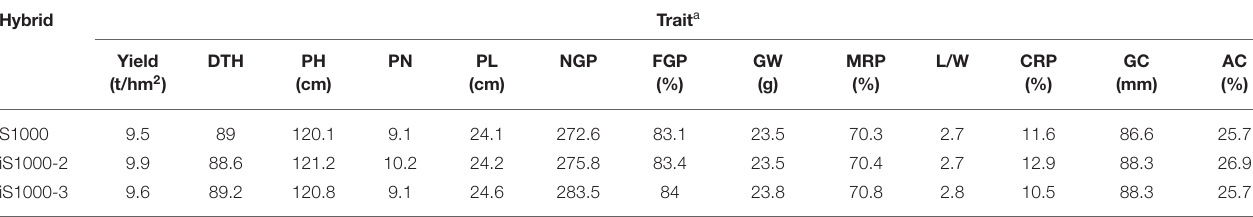
TABLE 5 | The performance of yield, main agronomic, and grain quality traits of the iS1000 hybrids. Hybrid Trait a Yield (t/hm 2 )